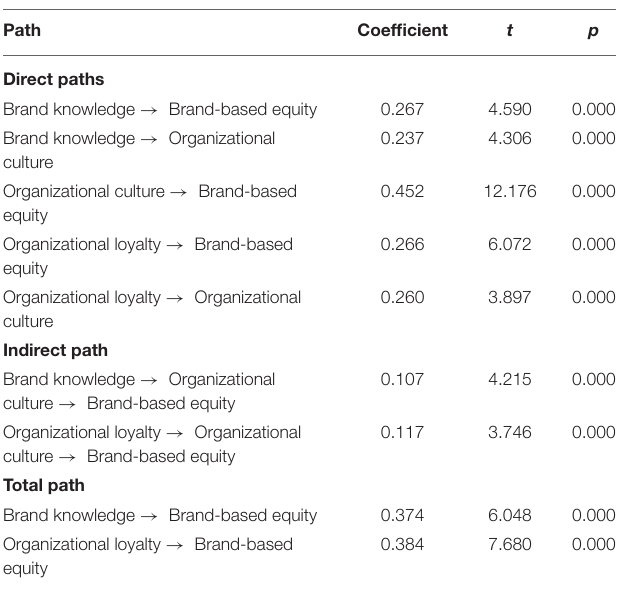
TABLE 6 | Path estimation.